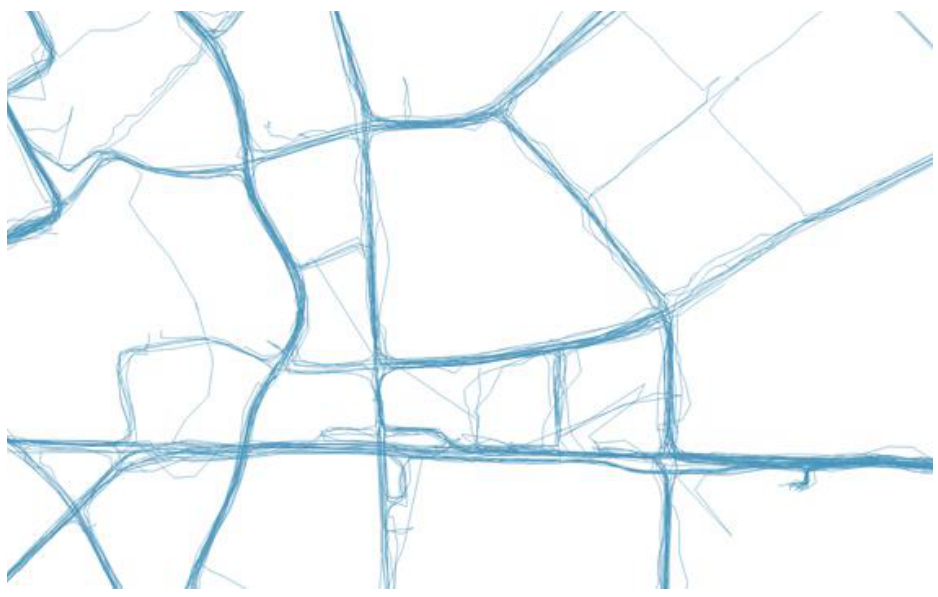
Figure 1. Vehicle trajectories during a certain period of a certain area.